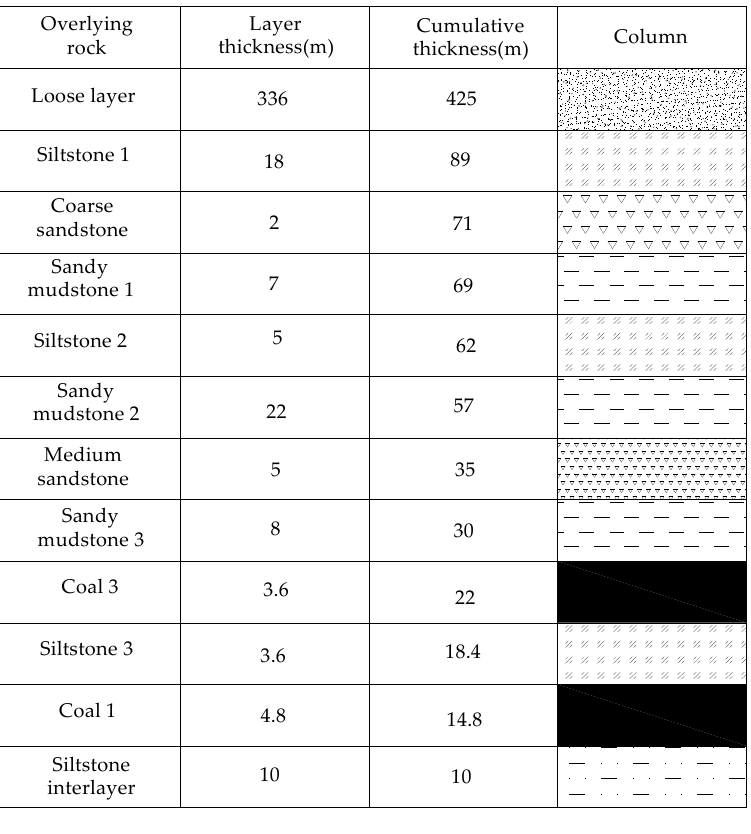
Figure 9. Stratigraphic information of the working face 11111.